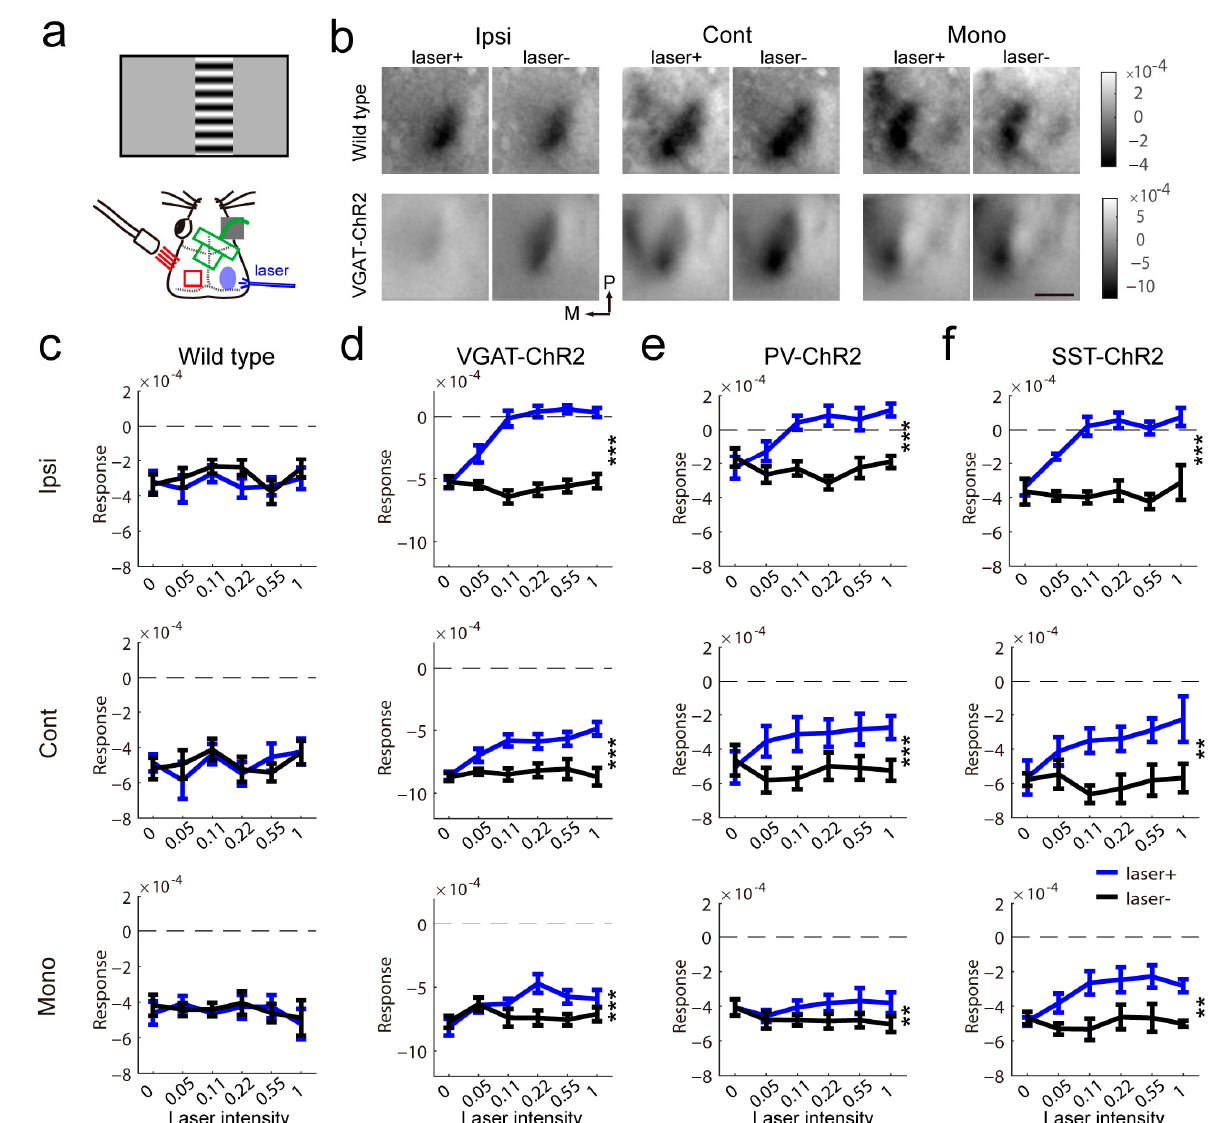
right shows the spatial activation pattern. The colored response curve was calculated from the region of interest outlined by the red dashed line in the response map. The scale bar is 0.2 mm. ( d – f ) The amplitude of the response of the left visual cortex depends on the laser intensity in VGAT-ChR2 mice (d, n = 4), PV-ChR2 mice (e, n = 3) and SST-ChR2 mice (f, n = 4).